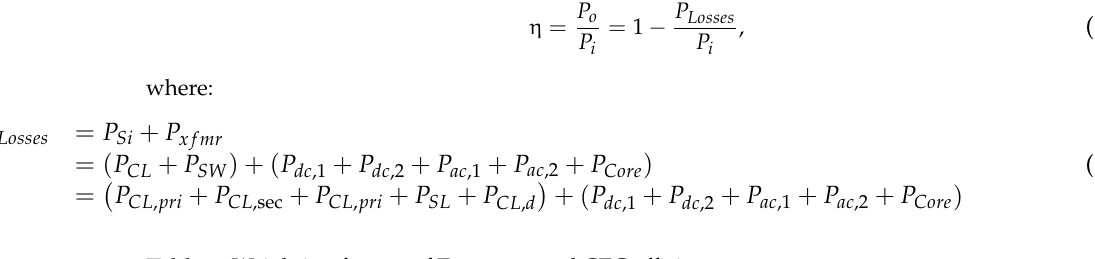
Table 1. Weighting factors of European and CEC